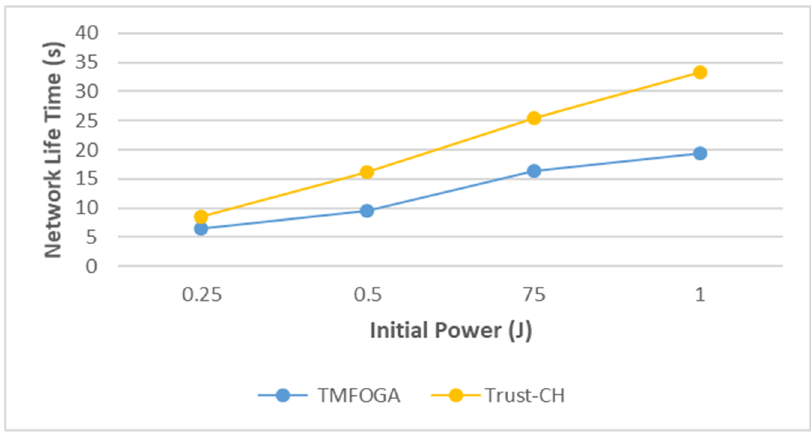
Figure 12. Comparison of Trust-CH and TMFOGA on network lifetime. 4.3. Threats Resistance In terms of security analysis, we used a Speck128 encryption algorithm that is known to be lightweight, fast and secure. As for authentication, it is also analyzed in [26]. Regard- ing attack types, we used eavesdropping, man-in-the-middle and replay attacks. The Flex- Crypt algorithm is used initially in the Trust-CH technique in an effort to lower the cost of authentication, key generation and integrity. Moreover, in an effort to cut costs by de- pending on the nodes’ shared confidence. After being designated as a trusted node, the